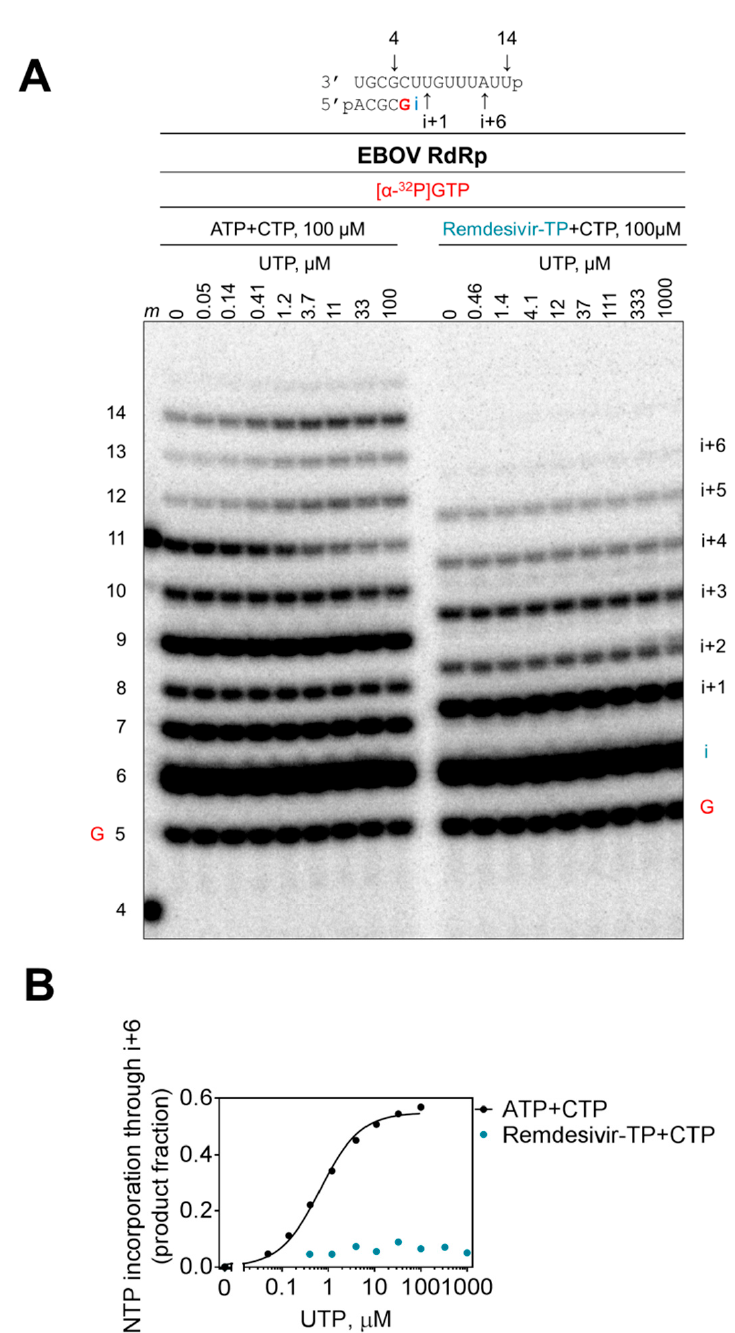
Figure 6. Effective delayed chain termination of RNA synthesis by remdesivir. ( A ) Remdesivir-MP-dependent delayed chain termination of RNA synthesis was studied with purified EBOV RdRp. RNA